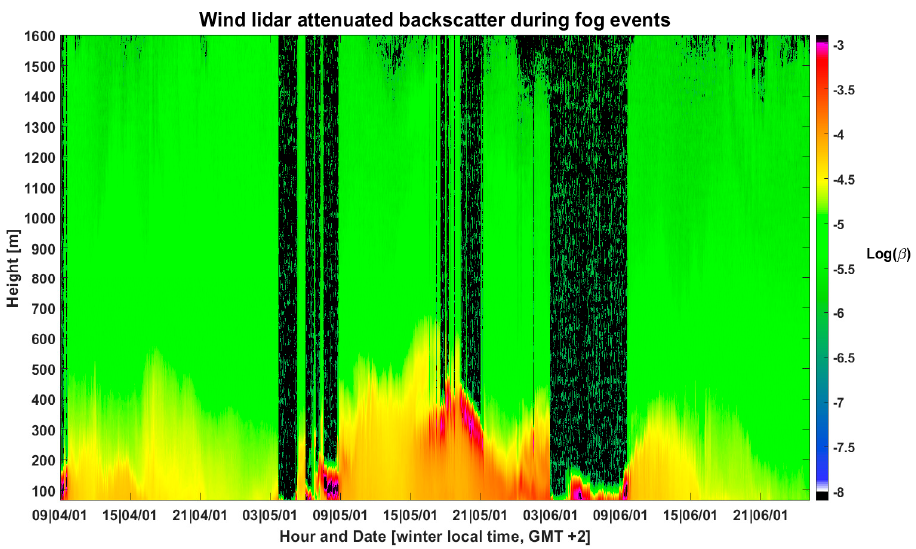
Figure 13. The backscattered Doppler Lidar during the fog events of 4 Janaury 2021–6 January 2021 in Nes Ziona.